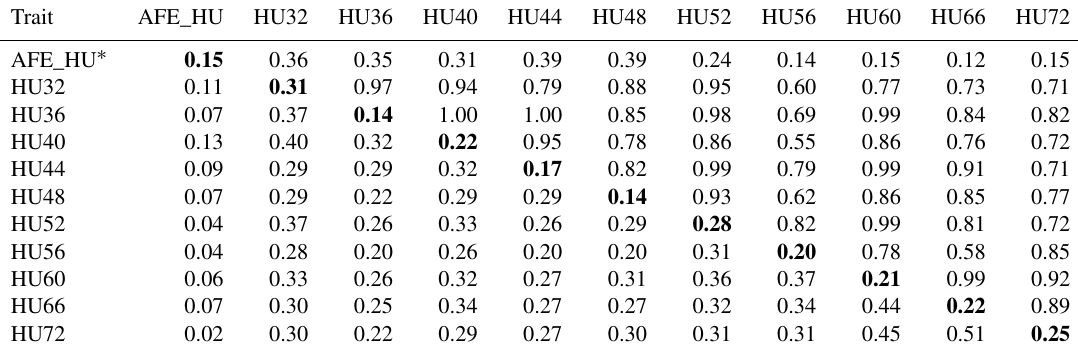
Table 3. Phenotypic correlation and genetic parameters of Haugh units (HU). Trait